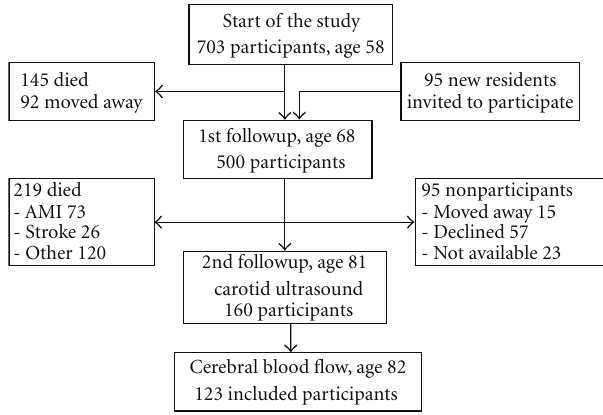
Figure 1: Followup of the cohort “Men born in